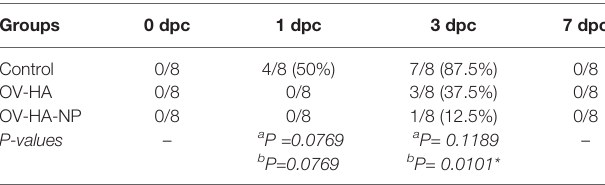
TABLE 2 | Virus isolation from the nasal swabs.